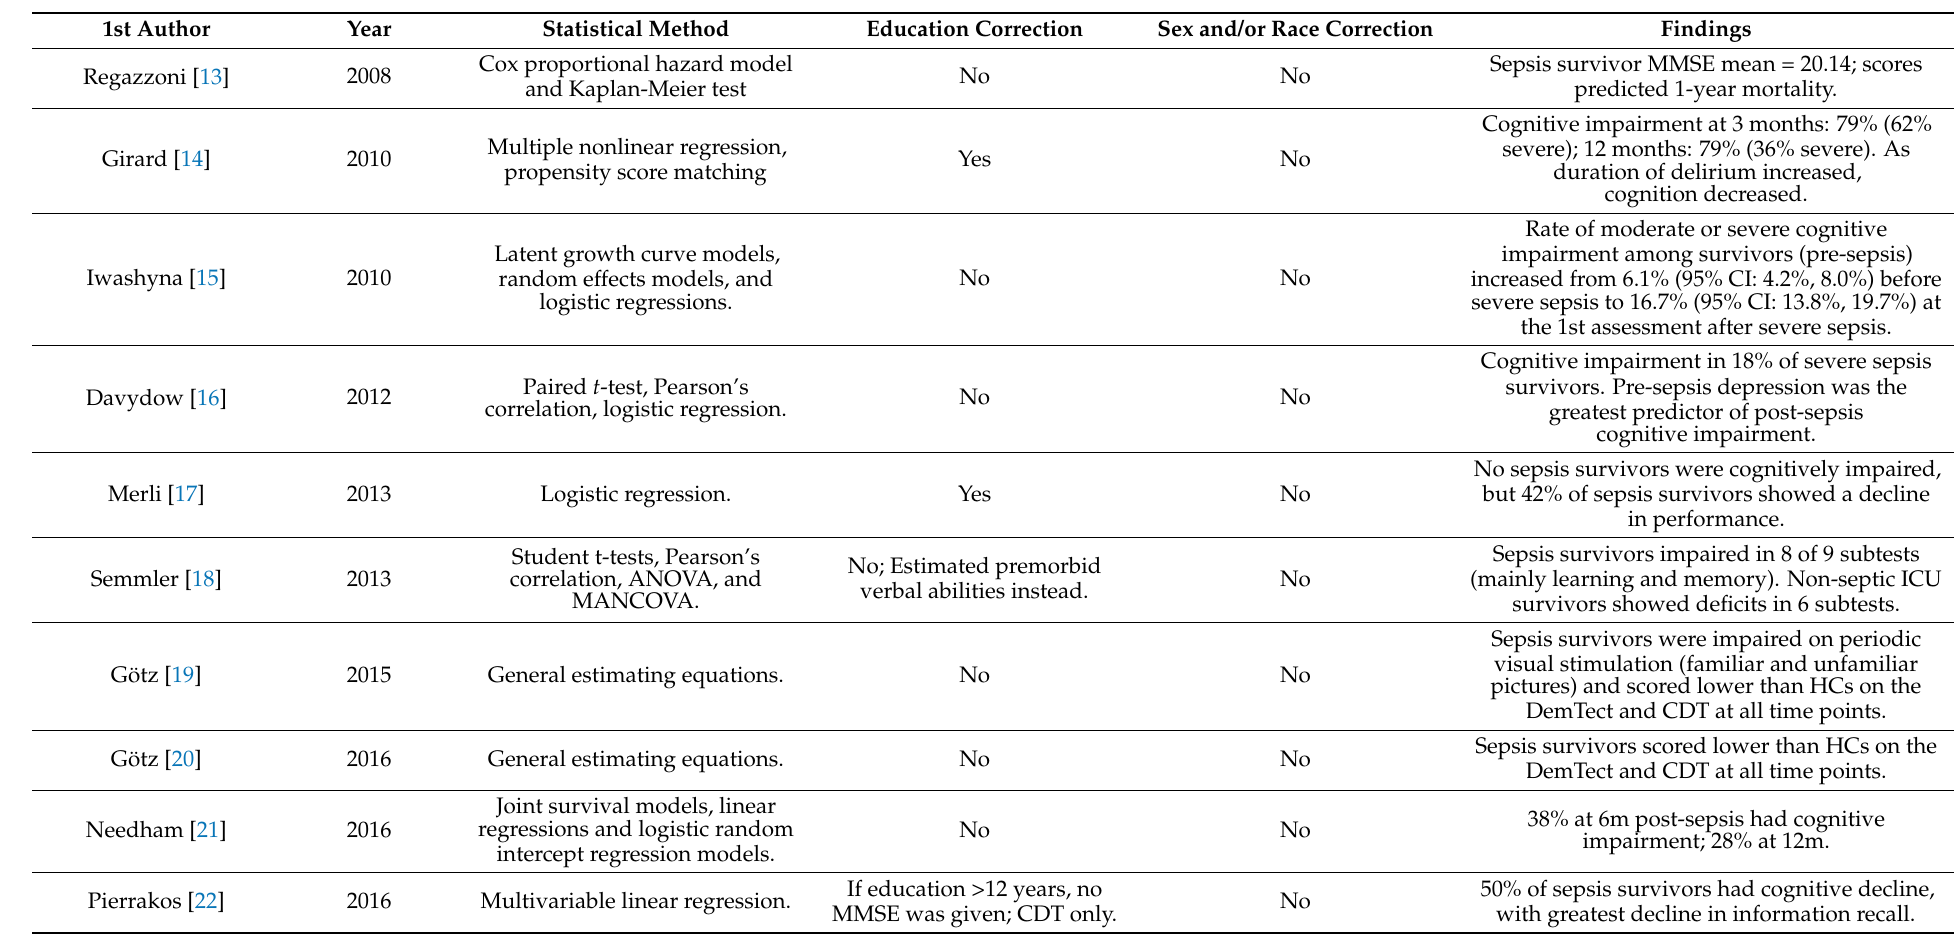
Table 3. Statistical Analyses and Corrections, and Summary of Cognitive